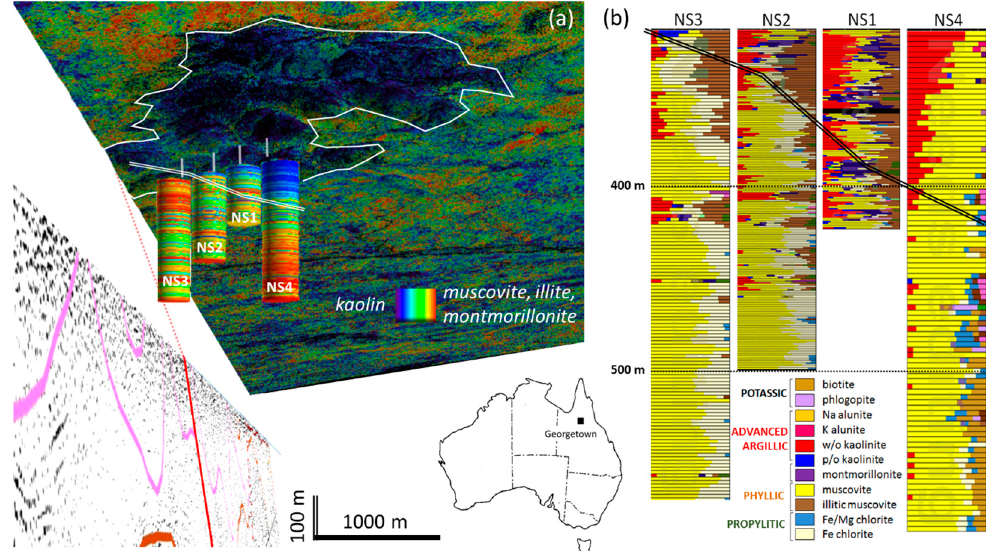
Figure 16. ( a ) Three-dimensional oblique view (up from the NE) of the Mt Turner porphyry–epithermal system near Georgetown. Area center is approximately − 18.2479° latitude 143.4473° longitude. Surface map is airborne HyMap™ convolved to ASTER bandpass configuration and then processed to generate a vegetation-unmixed Al-clay composition map before draping over a digital elevation model. The similarly color-coded vertical pillars are drill-core HyLogger™ data which also have been convolved to ASTER bandpass configuration and then processed to generate the same Al-clay composition product. The interpreted boundary between advanced argillic and phyllic alteration zonation is shown on both the HyMap™ (single line) and HyLogger™ (double line) results. Also shown is the vertical cross-section of a seismic line with pink lines showing granite contacts and red lines showing major faults; ( b ) Detailed mineralogy of the four HyLogger™ drill cores shown in ( a ) and generated using “The Spectral Assistant” in TSG™ software. The interpreted boundary between advanced argillic (comprises well-ordered kaolinite ± alunite) and phyllic (comprises muscovite/illite) alteration is shown by a double black line. Note that the NVCL drill cores start at fresh rock ~300 m below surface.